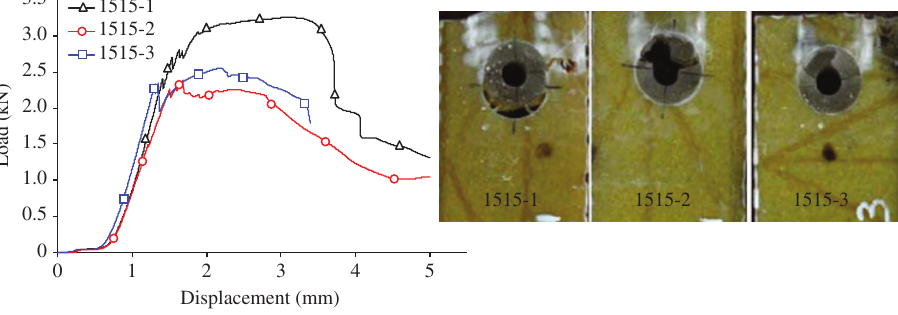
Figure 9 Load-displacement variations and images of the damaged samples for E = 15 mm and D = 15 mm.